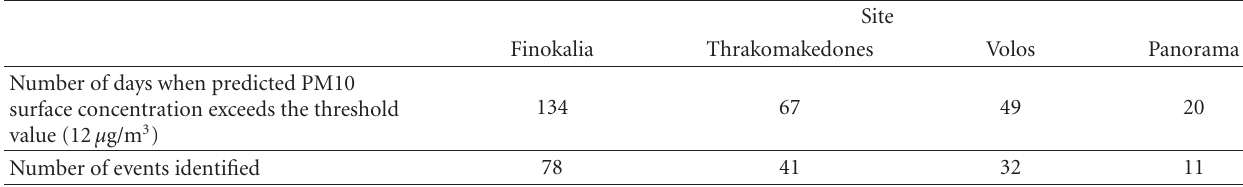
Table 2: Statistics for the selected dust outbreaks during the examined 7-year